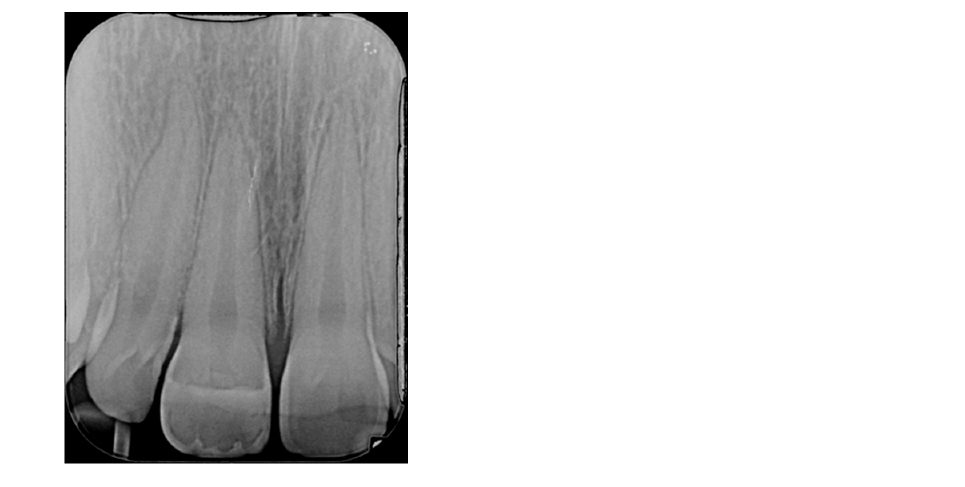
Figure 17. One year post-operative x-ray. Reprinted from Restauri diretti nei settori anteriori, G. Paolone, S. Scolavino, © 2021, with permission from Quintessence Publishing Italy.